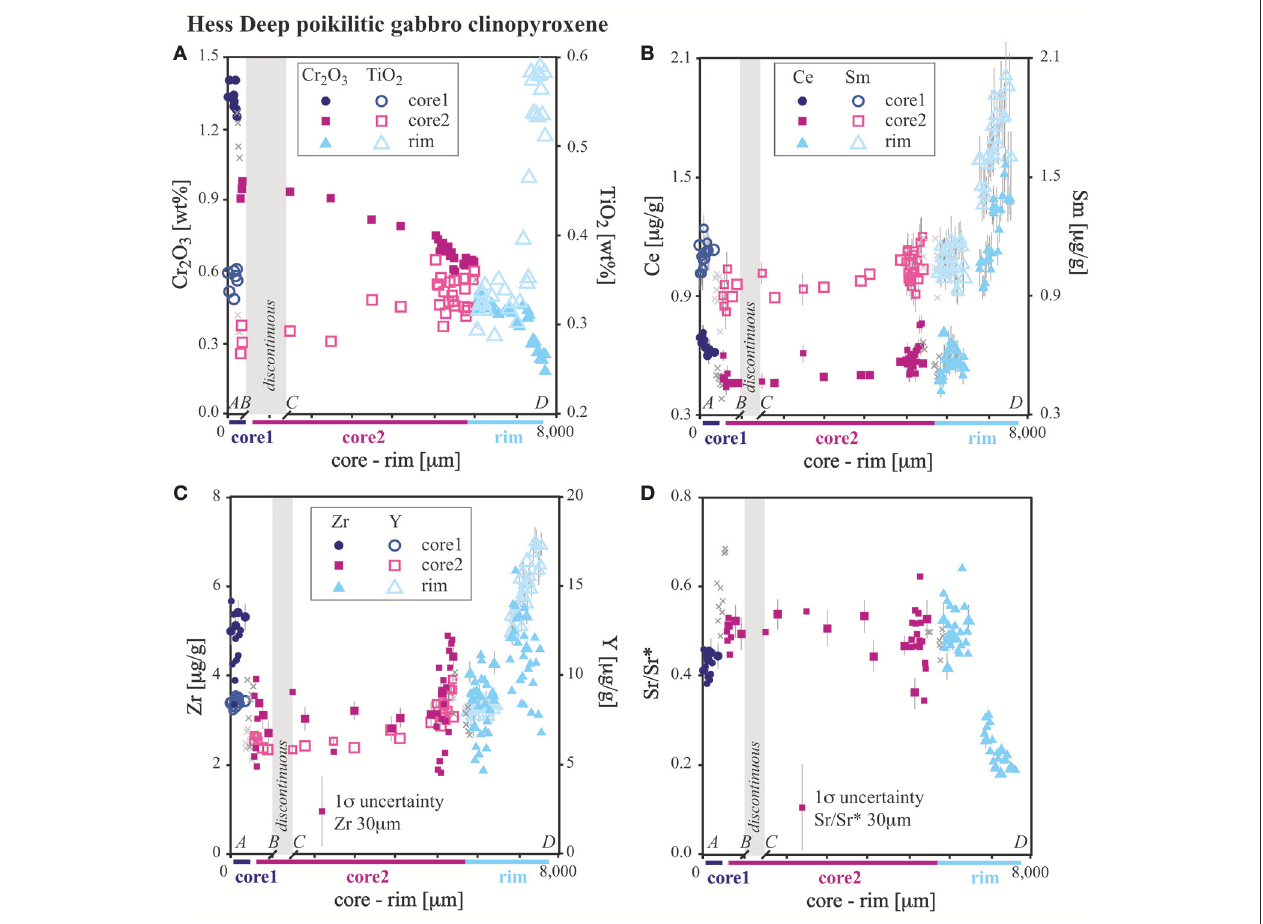
Figure 4 | Chemical variations across a zoned clinopyroxene in Hess Deep lower oceanic crust poikilitic gabbro: (A) Cr 2 O 3 and TiO 2 , (B) Ce and Sm, (C) Zr and Y and (D) Sr/Sr*. See profile locations in Figures 2C,D (core1 HD -core2 HD : A,B, core2 HD -rim HD -outer rim HD : C,D). Geochemical profiles are very similar to those from the Kane Megamullion clinopyroxene oikocryst (see Figure 3 ). Gray crosses are non-plateau analyses, partly reequilibrated upon diffusion. Large symbols are LA-ICP-MS 51 µ m spot analyses. 1 σ error bars are shown for trace elements. Data in Table A.2